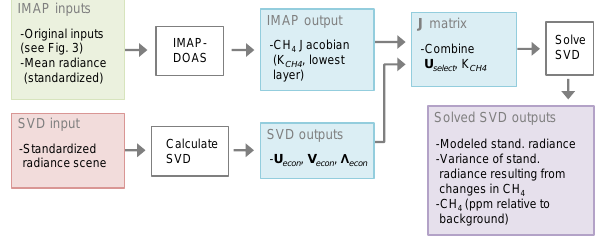
Fig. 5. Processing steps for the SVD retrieval method. The IMAP- DOAS retrieval is performed on a mean radiance for the image sub- set to generate the CH 4 Jacobian for the lowest layer. The SVD is used to calculate U econ , V econ , and 3 econ , while U select is com- bined with the CH 4 Jacobian to generate the J matrix. J is used to determine the portion of each radiance spectra associated with the CH 4 Jacobian (i.e., absorptions due to CH 4 ) and can be used to estimate CH 4